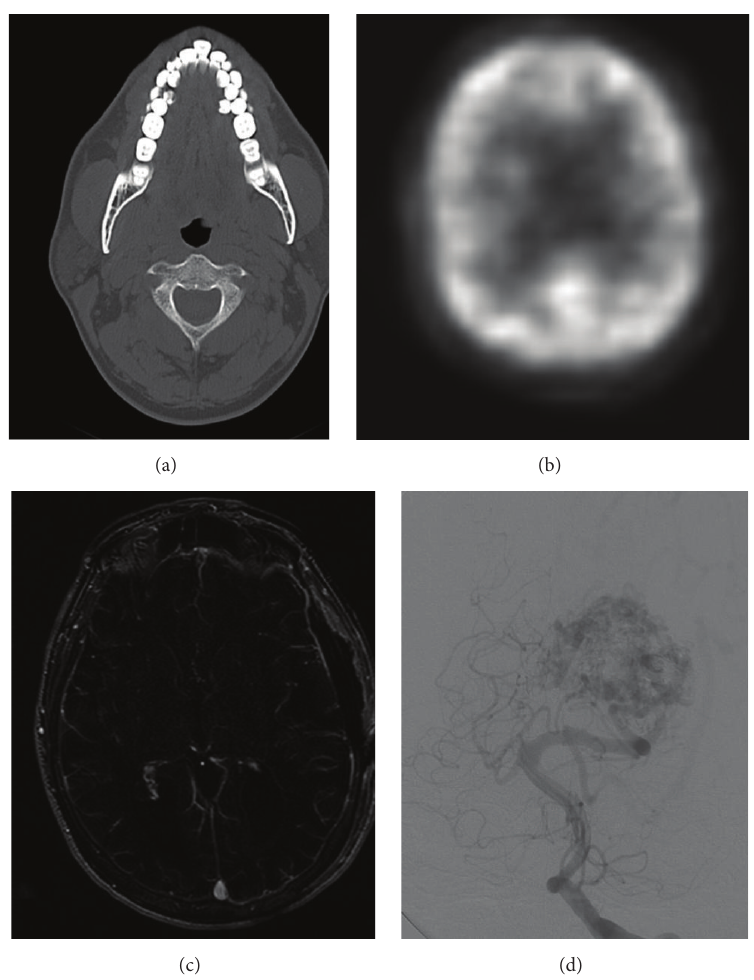
Figure 1: Sample medical images used in the experiment: (a) CT, (b) PET, (c) MR, and (d) XA.